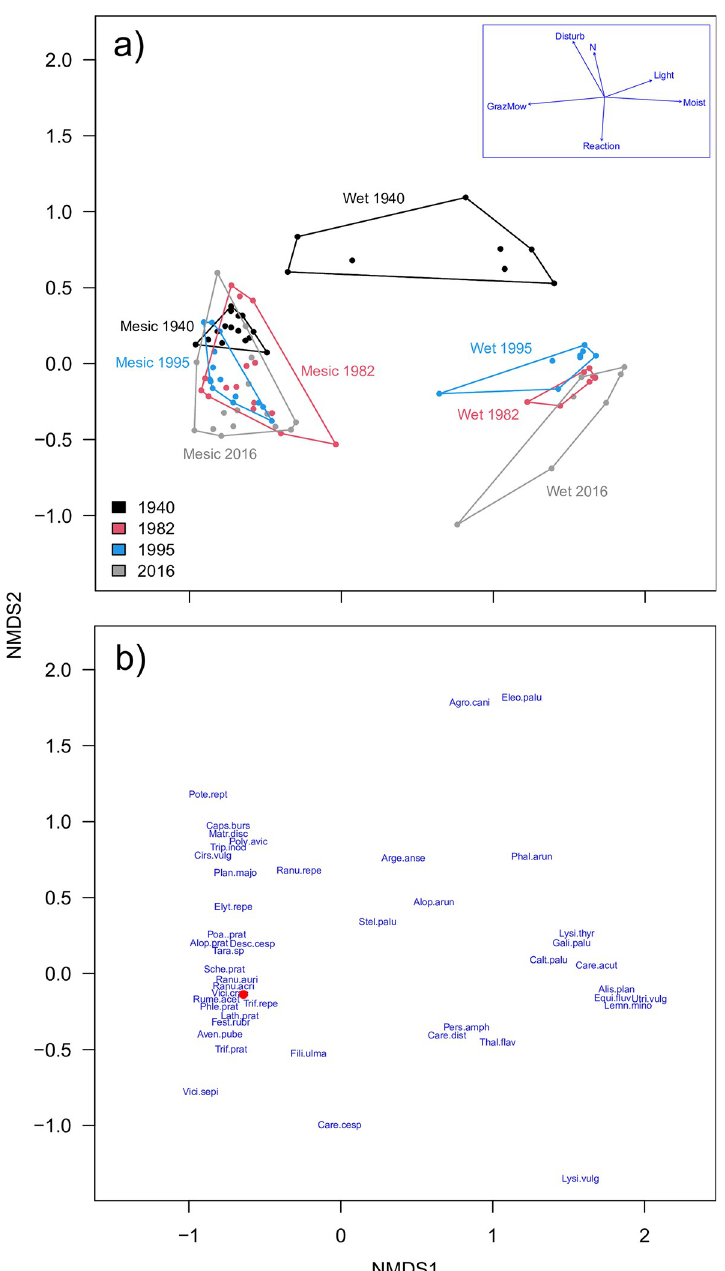
Fig 2. (a) NMDS ordination of plots in Profiles 1 on Kungsa¨ngen in 1940, 1982, 1995 and 2016. mesic plots, n = 15; wet plots, n = 8). NMDS stress = 0.07. Inset shows environmental vectors based on abundance-weighted indicator values for each plot. (b) Species ordination, showing the six most abundant species in each envelope and other representative species that are mentioned in the text (such as ruderals). The red dot is Fritillaria meleagris . Some species’ positions are slightly shifted to reduce text overlap. For full species names, see S2